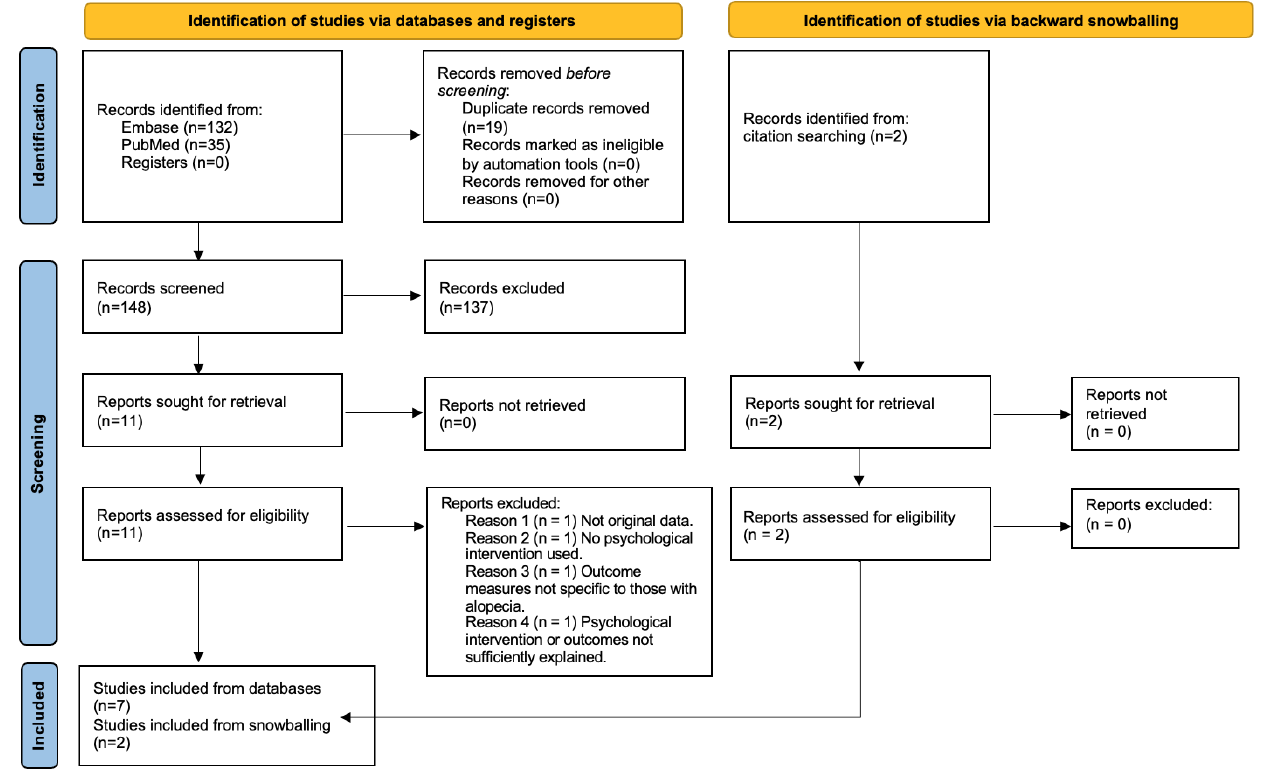
Figure 1. Flow chart of search strategy according to